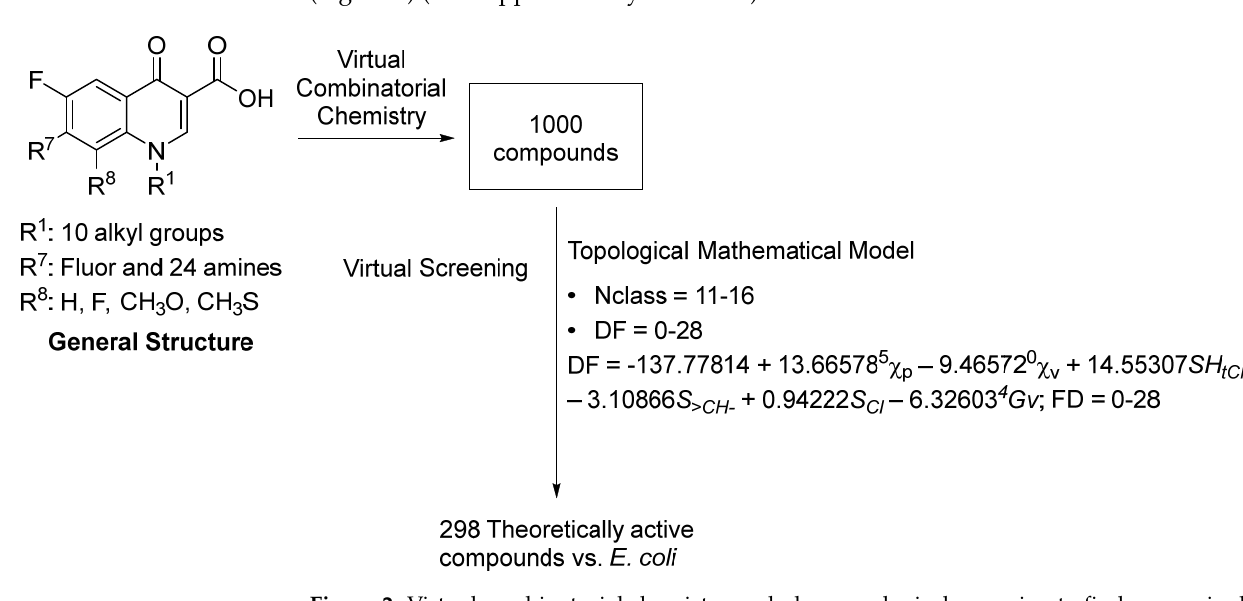
Figure 2. Virtual combinatorial chemistry and pharmacological screening to find new quinolones with theoretical antibacterial activity.